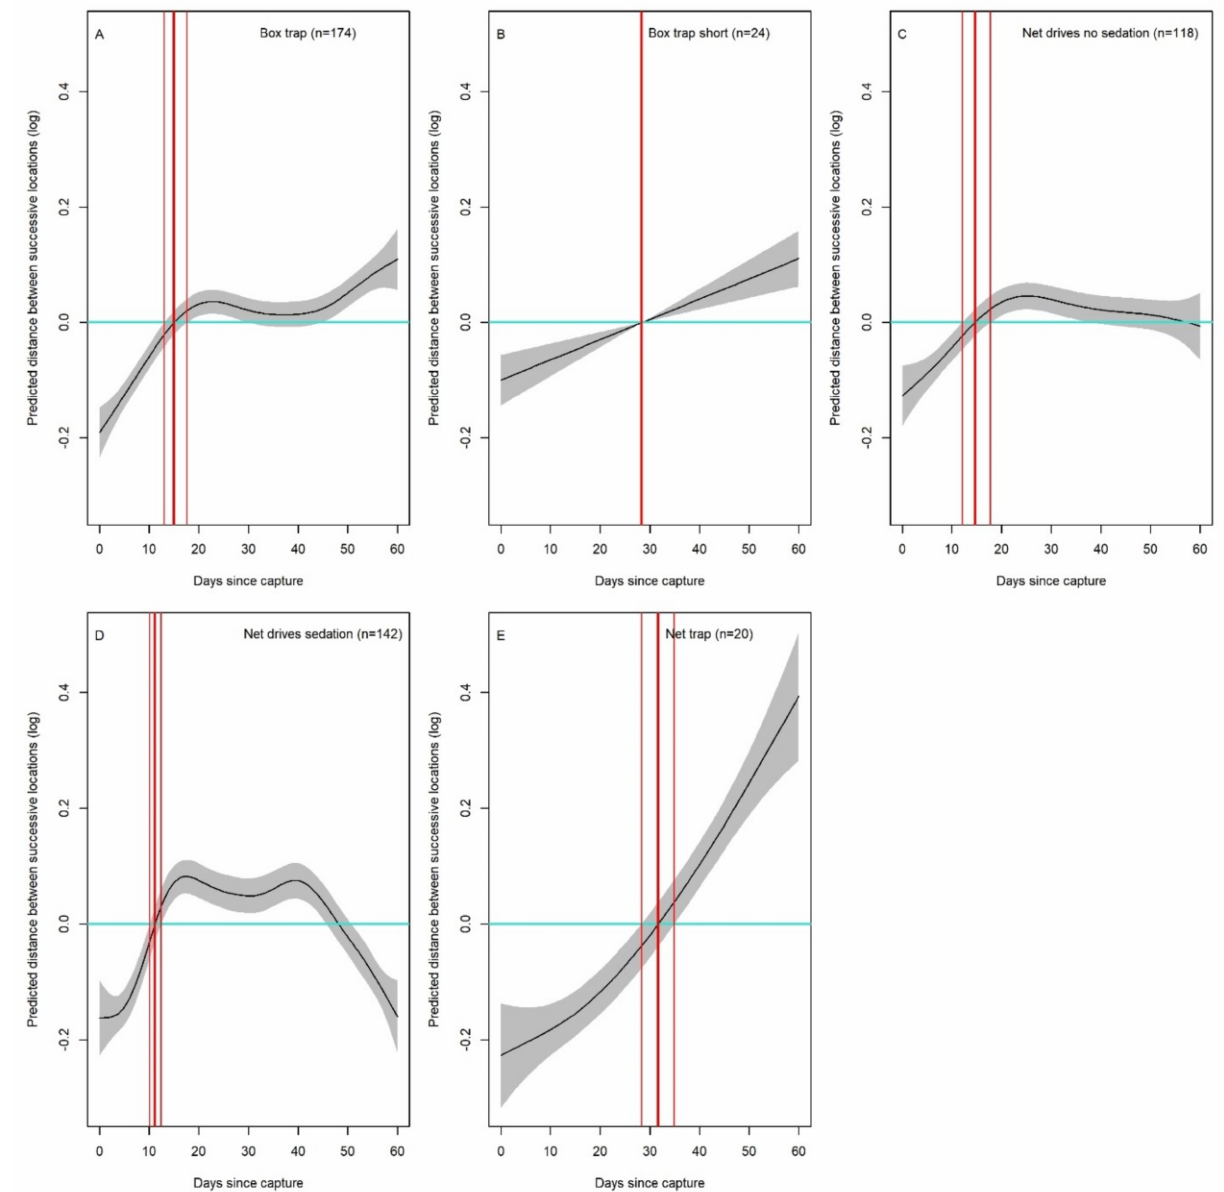
Figure 2. ( A – E ). Number of days after first capture and release to rebound to the average individual-specific distance (thick, red vertical line), the average distance +SE and the average distance − SE (thin red vertical lines) between successive locations, across the different capture methods. Light blue line: no effect (average distance). The model is centred on zero, i.e., the plotted value sum to zero that hence represents the average distance (blue line: no effect). When the line crosses zero, it implies the distance has ‘rebounded to overall average